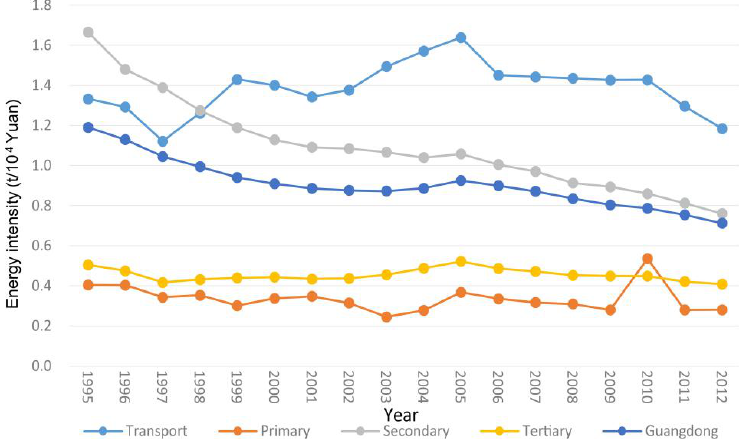
Figure 2. Energy intensity of transport sector, three main industries and the grand total in